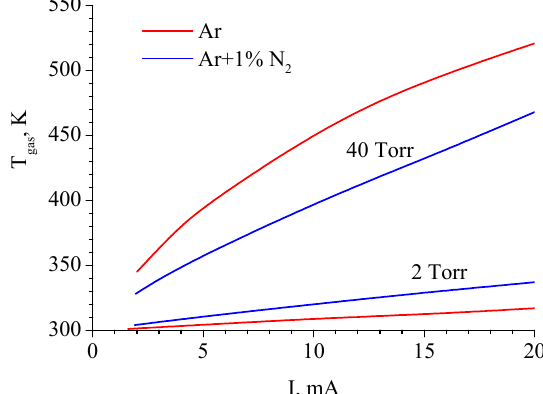
Figure 4. Gas temperature at the axis of the discharge tube calculated in pure argon and the Ar + 1%N 2 mixture for P = 2 Torr and 40 Torr [17].